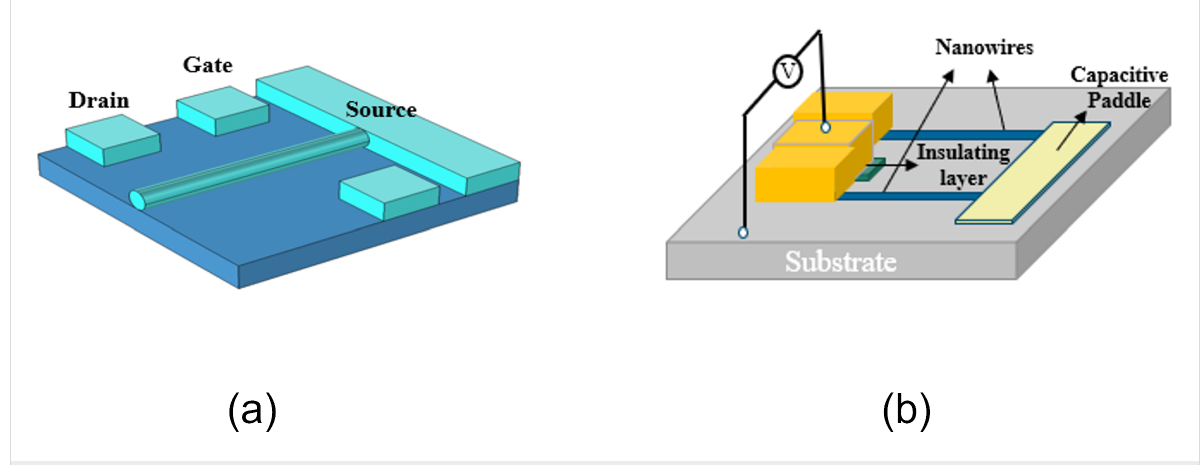
Figure 5: (a) Lateral structure and (b) U-shape structure of NW switches. Figure 5a,b were redrawn from [36,37], respectively.